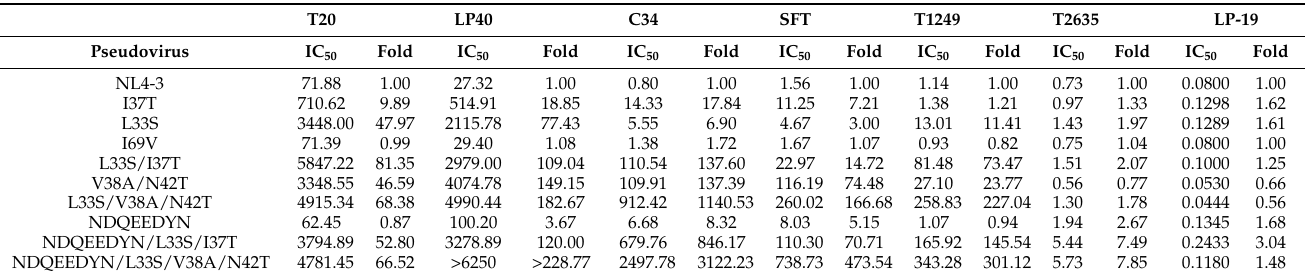
Table 3. Resistance profiles of mutations that belong to LP40-V12 to diverse HIV-1 peptide fusion inhibitors. The experiment was performed in triplicate and repeated three times. Data are expressed as means. Fold change in the IC 50 (nM)was determined relative to the WT (HIV-1 NL4-3 ) level. T20 LP40